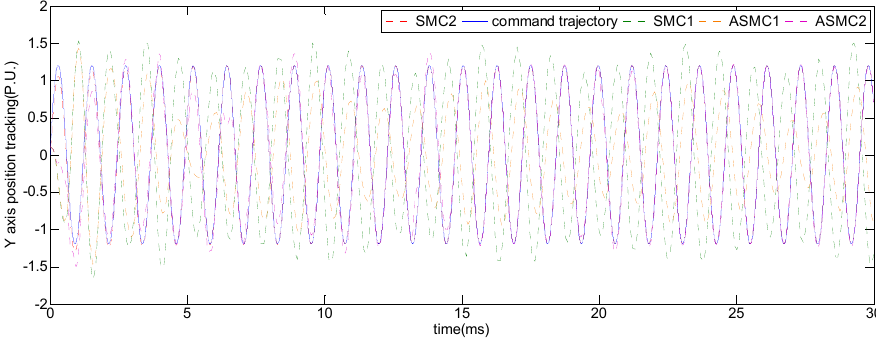
Figure 7. Y axis tracking error comparisons of SMC2, SMC1, ASMC2, and ASMC1. Choosing SMC2 and ASMC2 for comparison, system tracking performance using APPSMC is provided in Figure 8 and 9. It can be seen that system dynamic can track the command trajectory